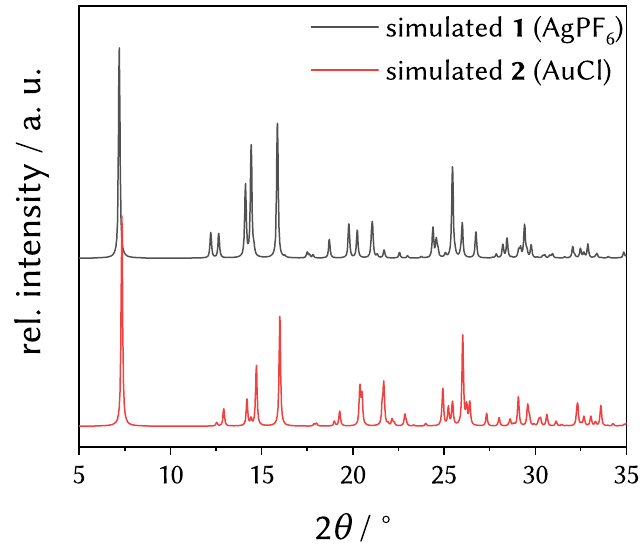
Figure 5. Simulated powder X-ray diffractograms of 1 (black) and 2 (red) in